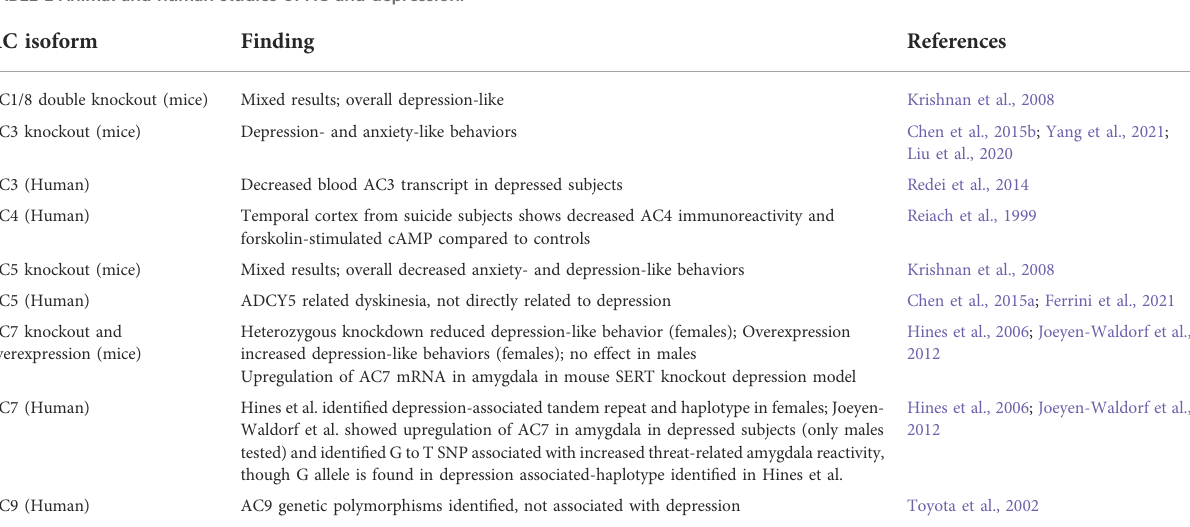
TABLE 1 Animal and human studies of AC and